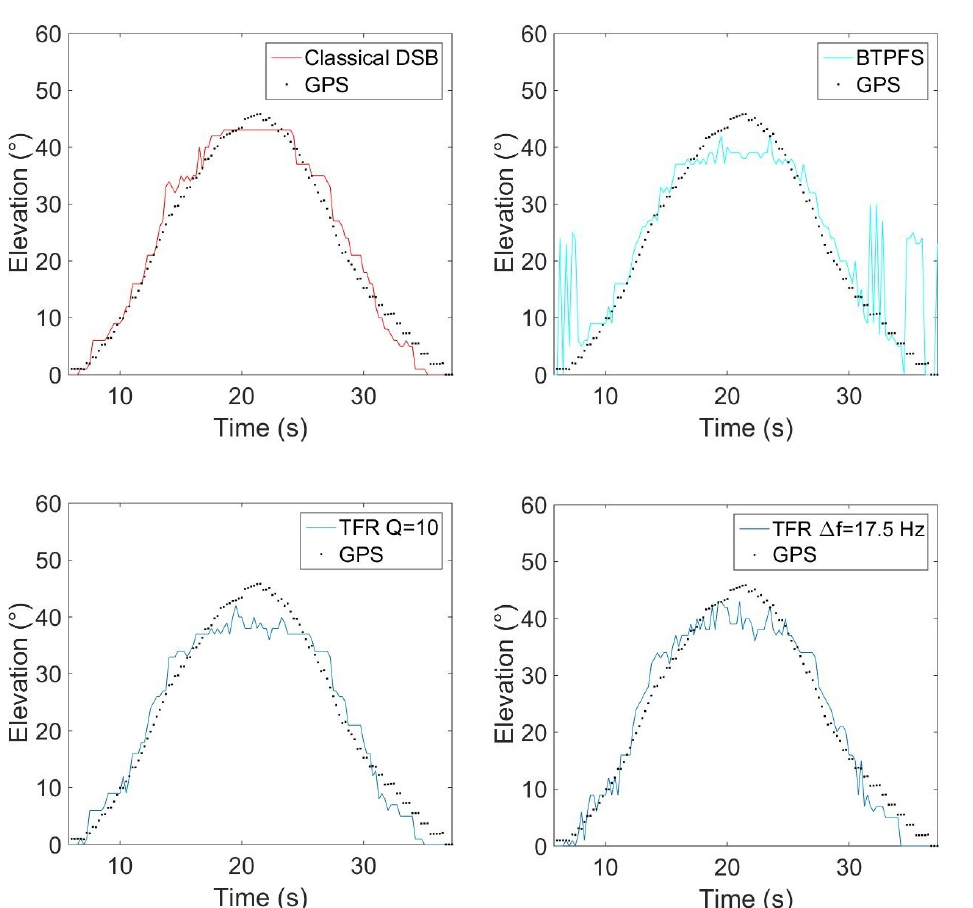
Figure 16. Evolution of the elevation with time for the experimental trajectory, for the two types of bandwidth, with Q = 10.